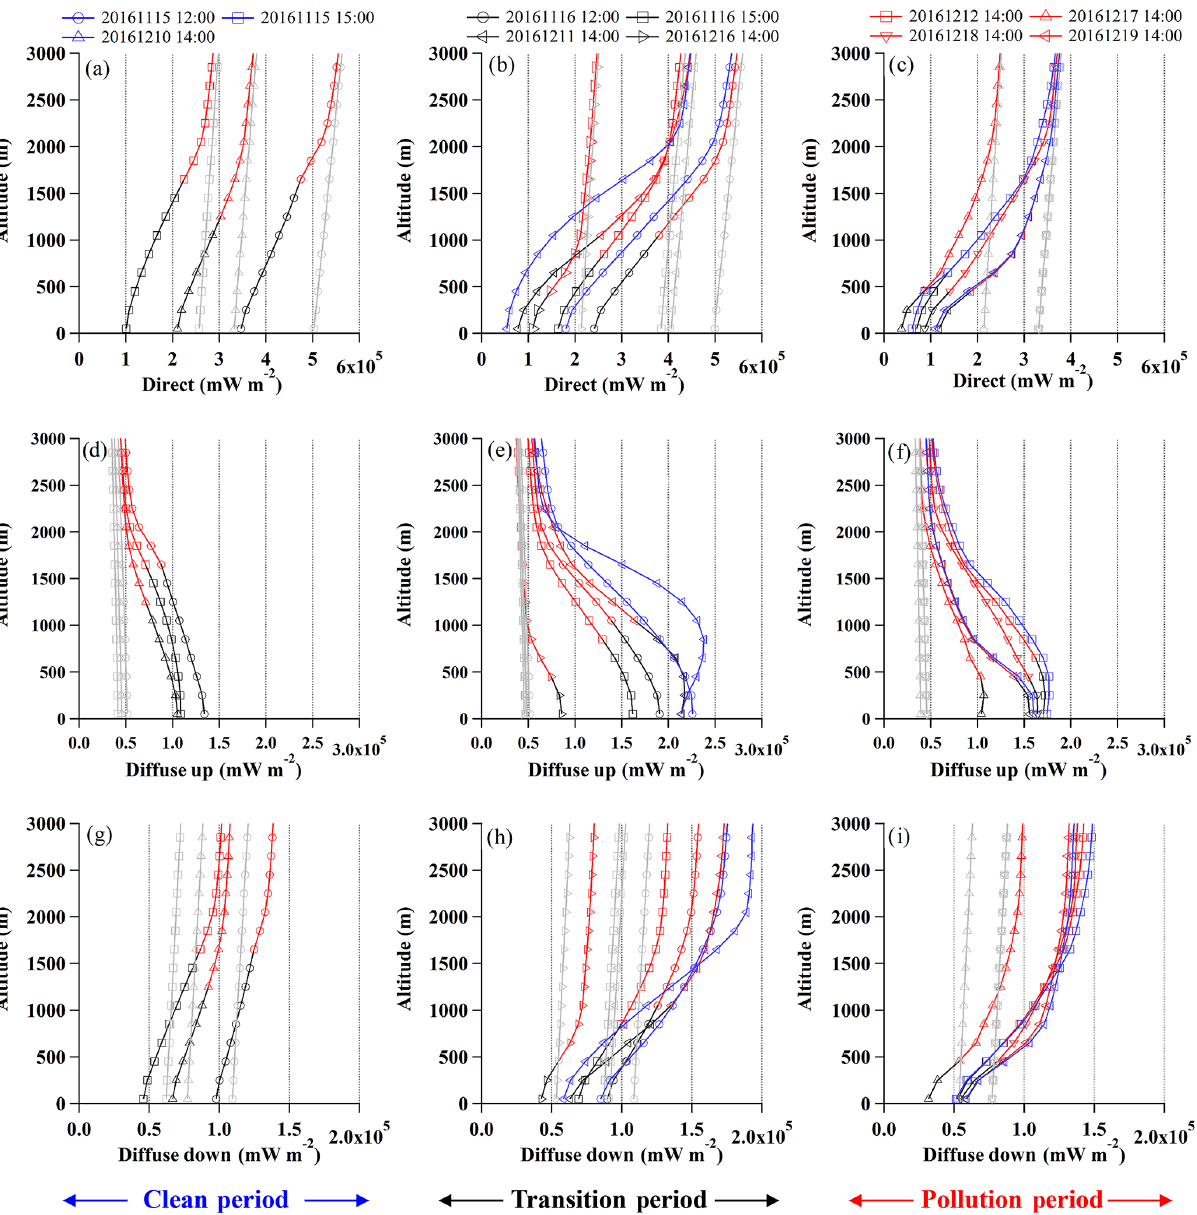
Figure 6. Radiative transfer results calculated by DISTORT. (a) – (c) , (d) – (f) and (g) – (i) show the direct, diffuse upward and diffuse downward irradiance, respectively. The left, middle and right panel represent CP, TP and HP respectively, with black and red lines denoting the area above the PBL and within the PBL. The coloured (all colours except for grey) and grey lines denote the profiles with and without aerosol influence, respectively, and the blue lines are for corrected hygroscopic